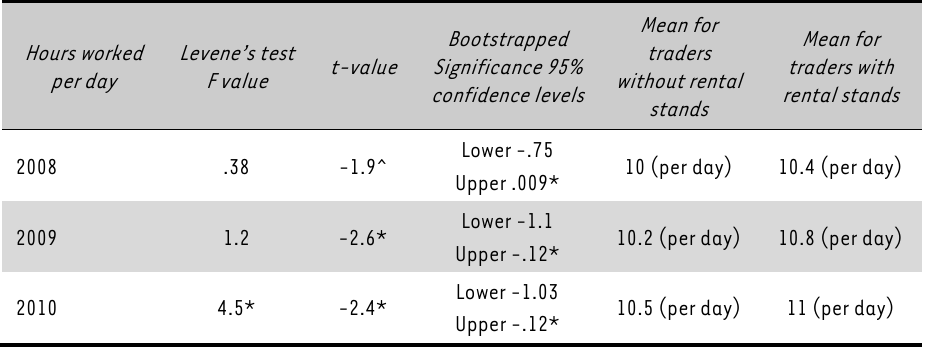
Results of the t-tests for differences in Hours Worked per day Hours worked per